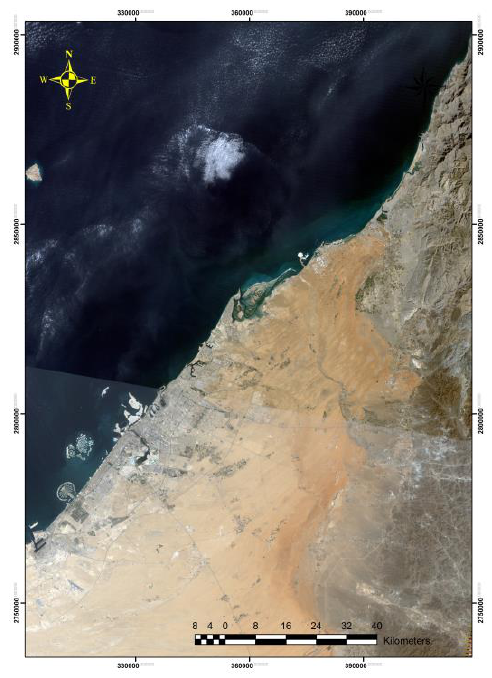
Figure 1. Landsat Image for study area (Northern part at